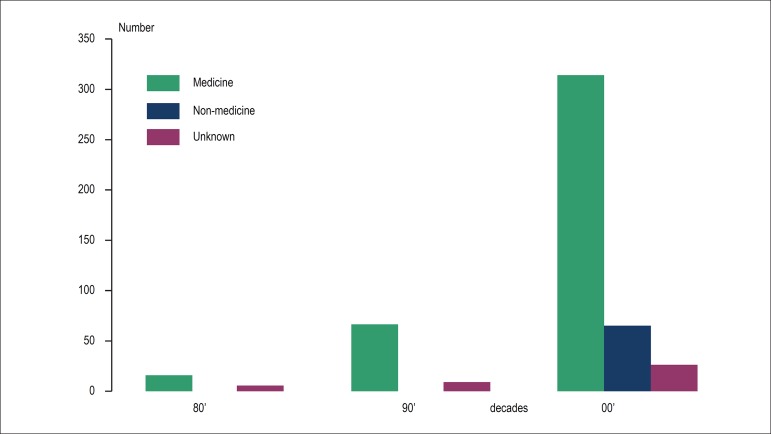
Postgraduate students with previous medical training versus no
medical training.